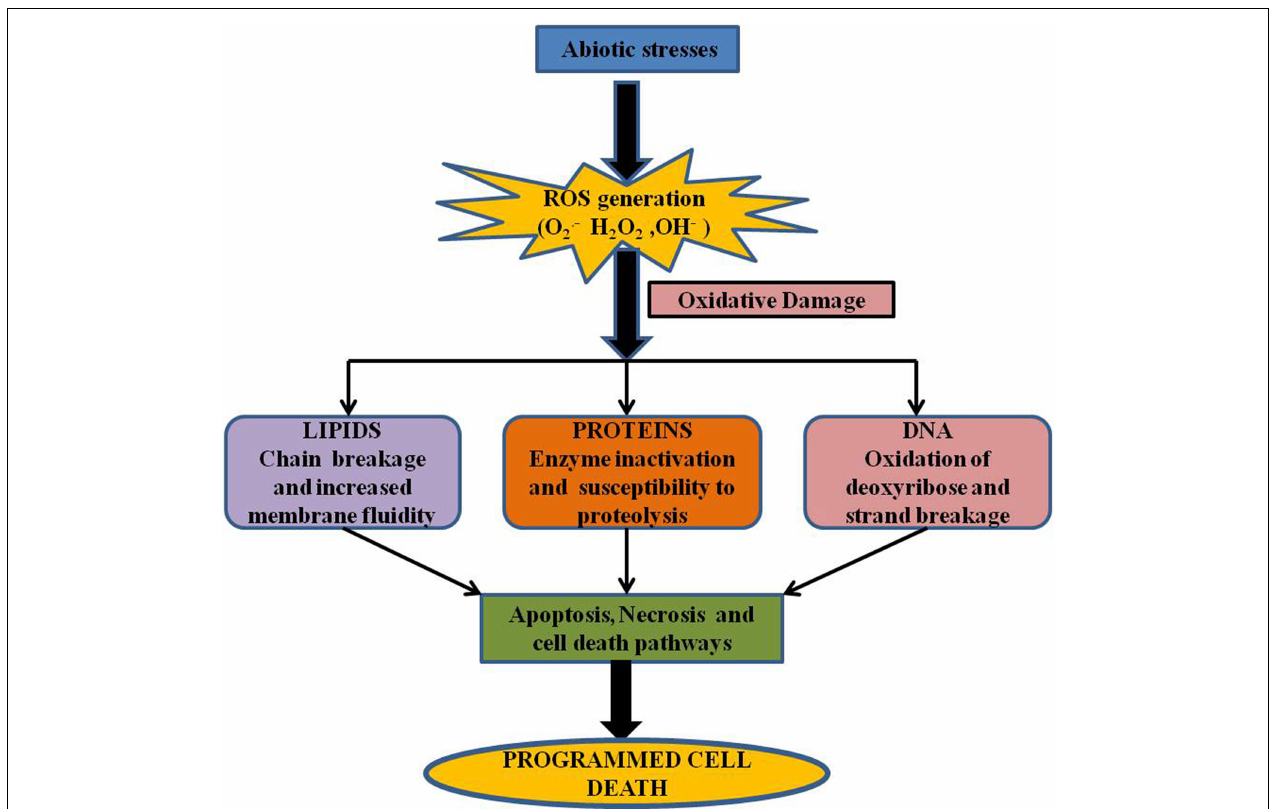
rangeofstressresponses.Exposureofcellstosevereoxidativestresscanelicit lethalresponsepathwayssuchasapoptosis,necrosis,andpossiblyotherforms of cell death pathways which can ultimately lead to programmed cell